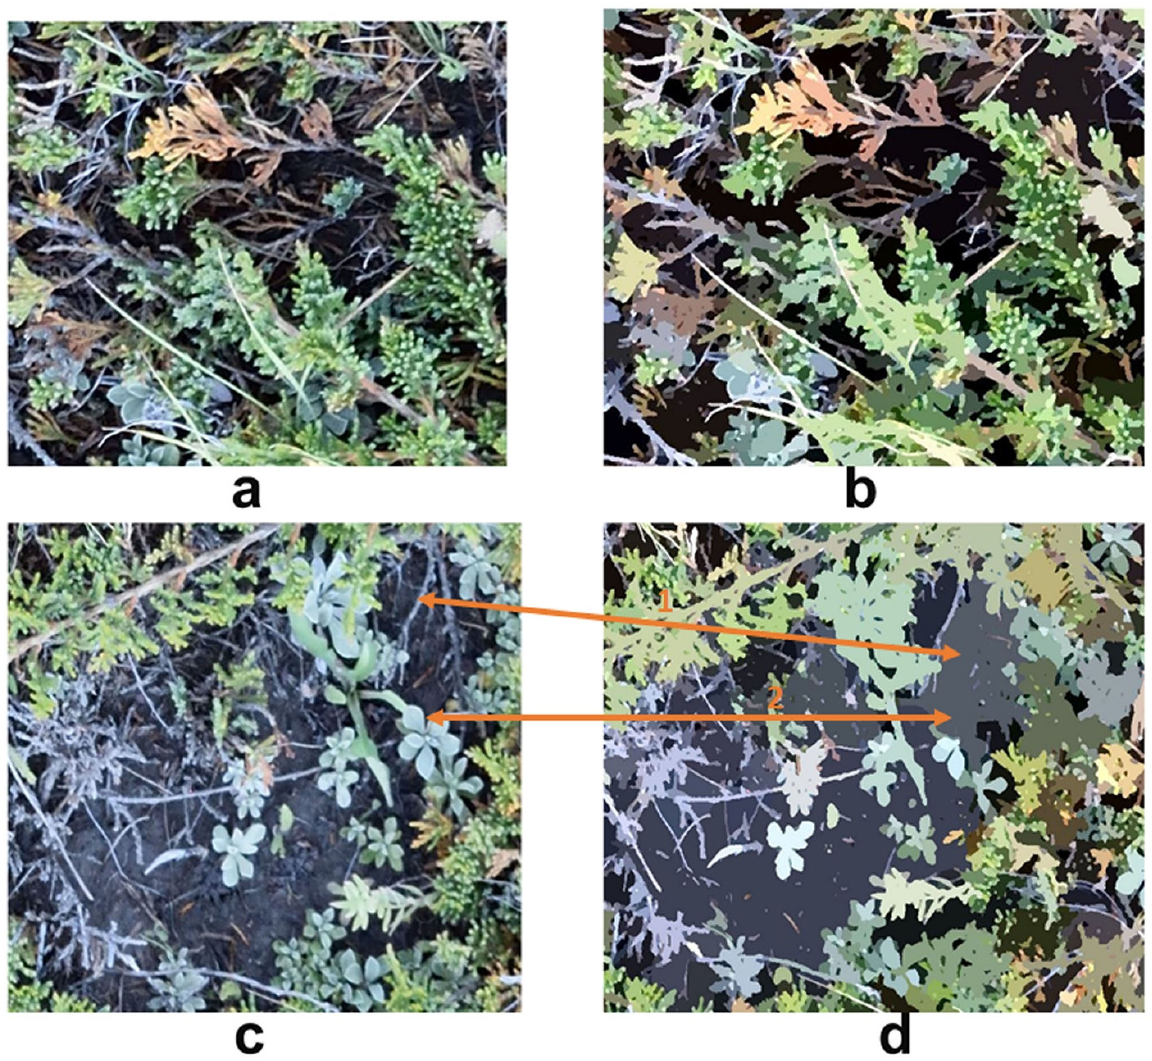
Figure 10. Comparison between the original image and OBIA region means: ( a ) original image (vegetation (grass and shrub) dominated), ( b ) OBIA region mean of ( a ), ( c ) original image (bare-soil dominated), and ( d ) OBIA region mean of ( c ). ( a , b ) are subsets of site EC2, plot E3 (shrub ( Juniperus ) dominated). The scale level was 50 and the merging level was 10.